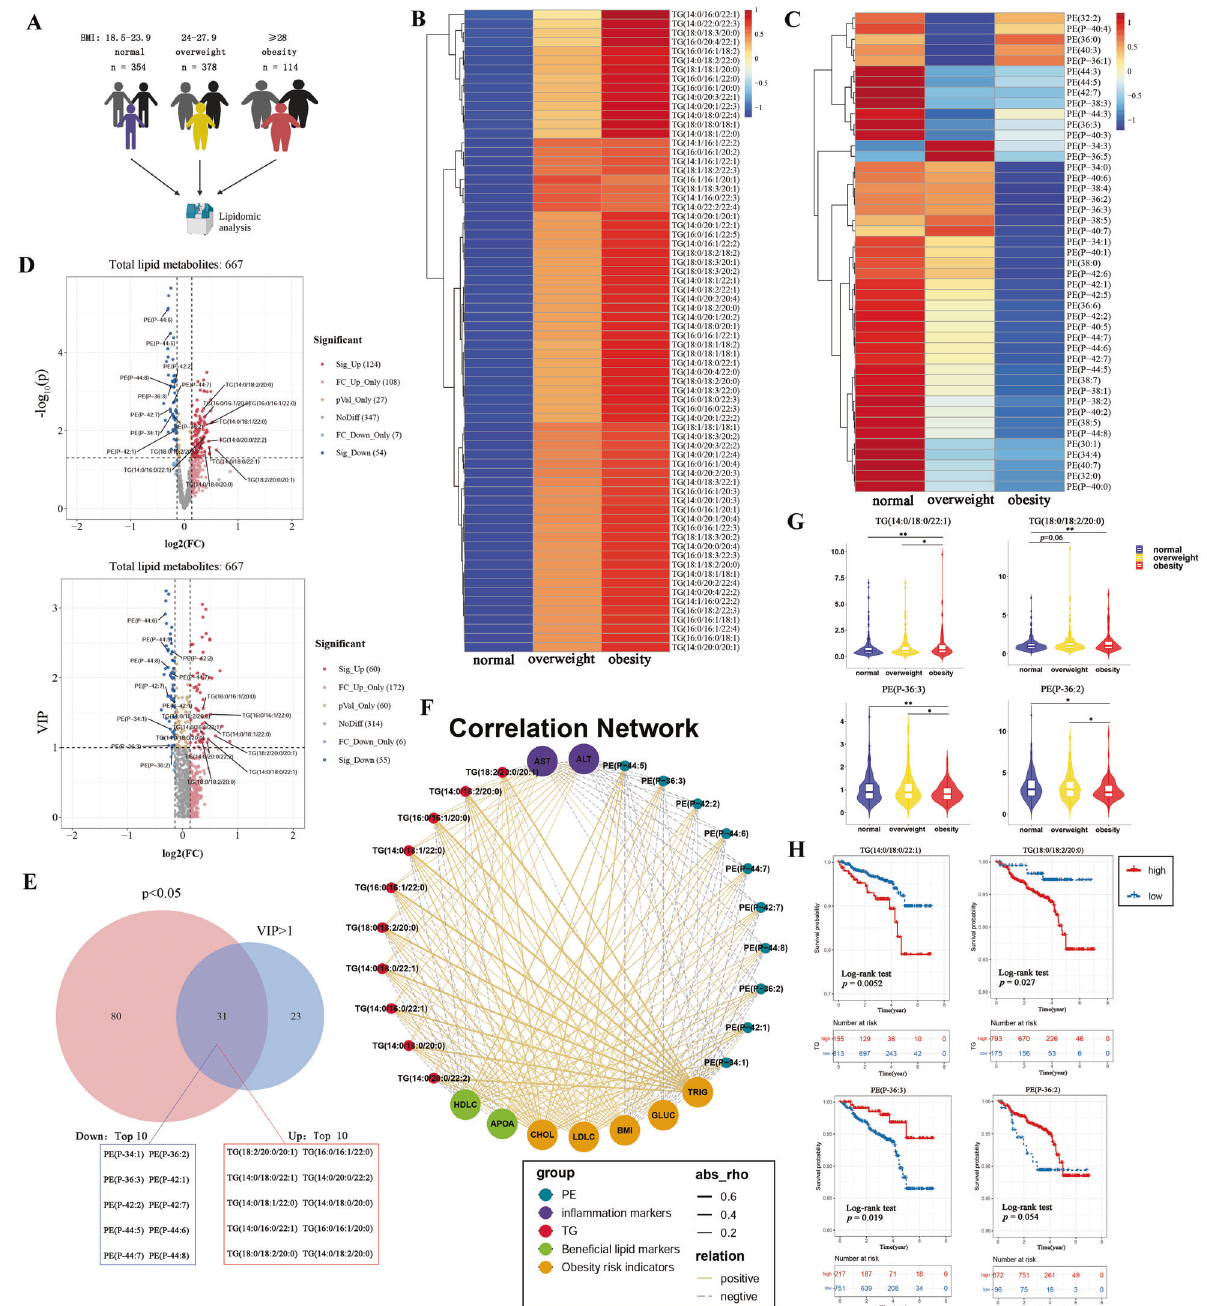
Fig. 1 Lipid disturbances were associated with the elevation of TG and the reduction of PE. A Experiment schematic for lipidomic analyses grouped by BMI according to the Chinese reference standard. B Heatmap of TG species containing different lengths of fatty acids in the three groups of patient plasma samples of normal, overweight, and obesity. The increased TG species code the color as red in the heatmap; the decreased ones code blue. C Heatmap of PE species containing different lengths of fatty acids in the three groups of patient plasma samples of normal, overweight and obesity. The increased PE species code the color as red in the heatmap; the decreased ones code the blue. D The volcano plots showing the differential lipid metabolite level between group normal and obesity. E Venn diagram showing the overlapping and accession-speci fi c differential lipid metabolites. Combined with VIP value (VIP > 1) and P value ( P < 0.05), the top ten PE and TG lipid metabolites with the most signi fi cant differences have been listed, and then marked in volcano plots. F Correlation network among the biochemical indicators and the top ten PE and TG lipid metabolites with the most signi fi cant differences. APOA apolipoprotein A, HDLC high- density lipoprotein cholesterol, ALT alanine aminotransferase, AST aspartate aminotransferase, LDLC low-density lipoprotein cholesterol, BMI body mass index, GLUC blood glucose, CHOL cholesterol, TRIG triglyceride. G Violin plot of individual TG and PE species included in the list of the top ten lipid metabolites with the most signi fi cant differences. The width of the graph represents the distribution probability of the y axis value, re fl ecting the overall distribution of the data. * P < 0.05; ** P < 0.01. H The TG or PE species shown in the violin plot were divided into a high (red) and low (blue) group according to the content, and Kaplan – Meier analysis was performed to compare survival for patients with high (red) and low (blue) TG or PE species. The surv_cutpoint function determines the best cut point for continuous variables (log-rank test, P values were displayed in the corner). See also Supplementary Fig. S1. Cell Death and Disease (2023)